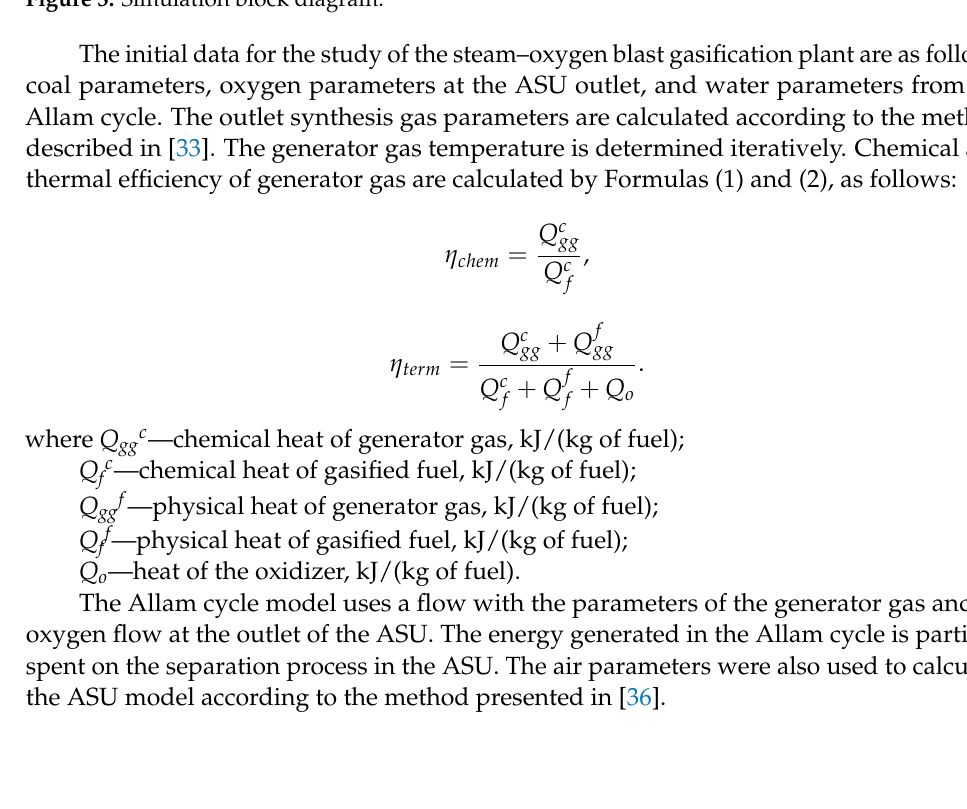
Figure 3. Simulation block diagram.